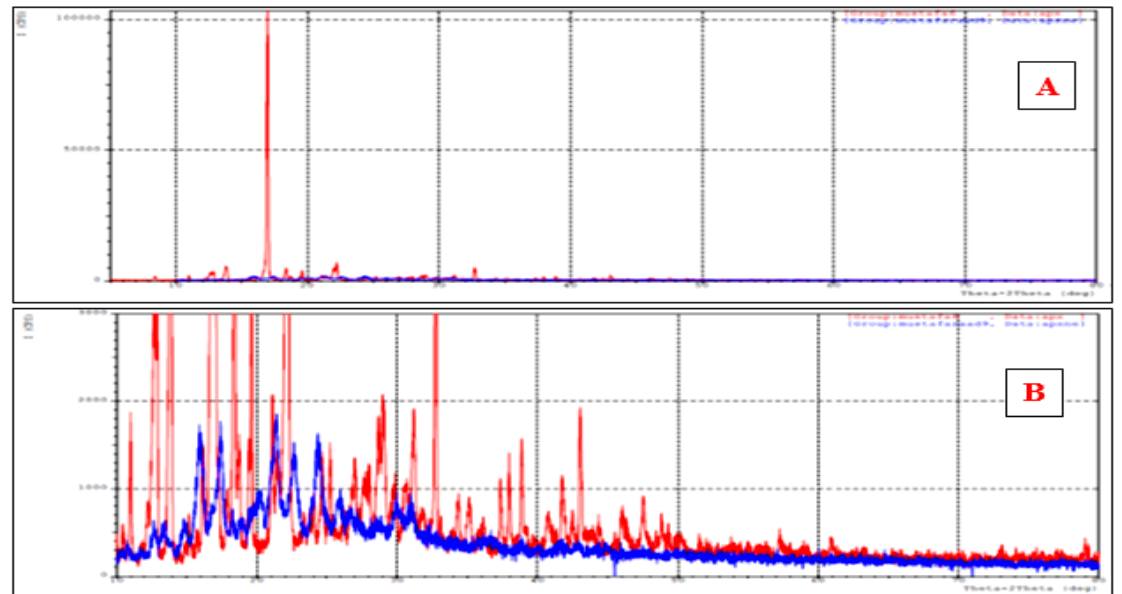
Figure 3. Comparative XRD of APX (blue) and APX-NE gel (red) at intensity (A) 100000 and (B) 3000. Microscopic morphology